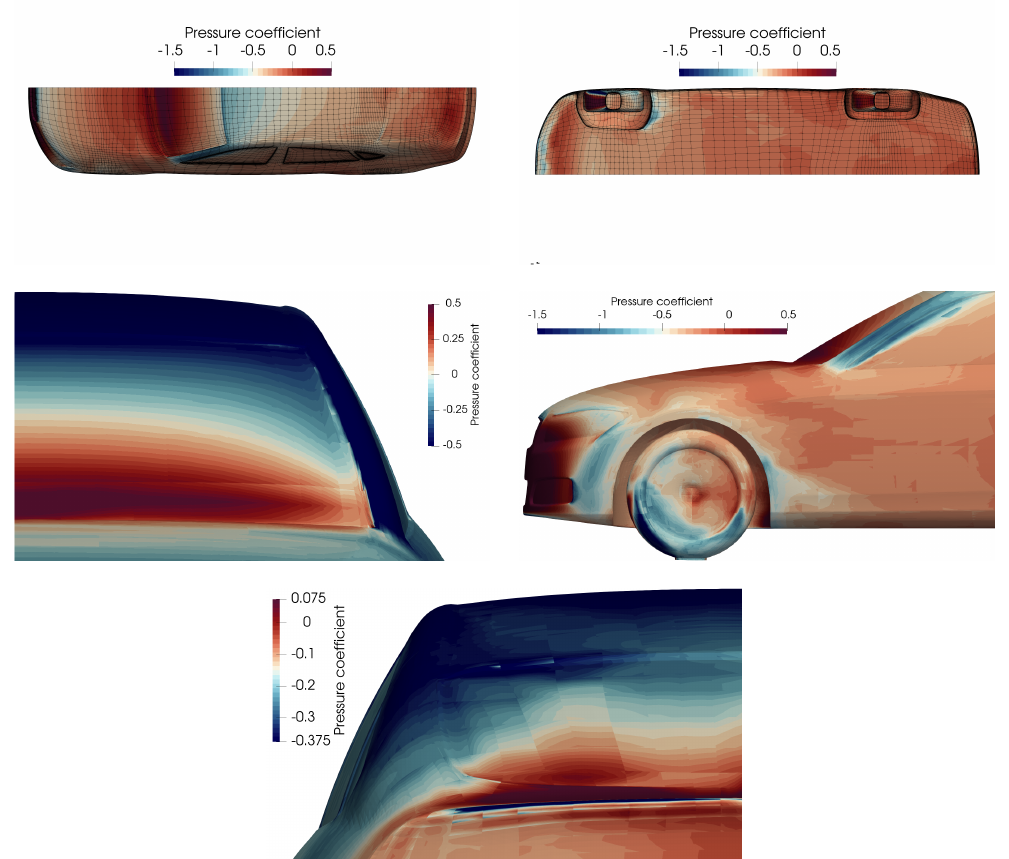
Figure 16. DrivAer model—Time-averaged pressure coefficient distribution on the body ( top-left ), the underbody ( top-right ), the windshield ( middle-left ), the front side window ( middle-right ) and the back window ( bottom